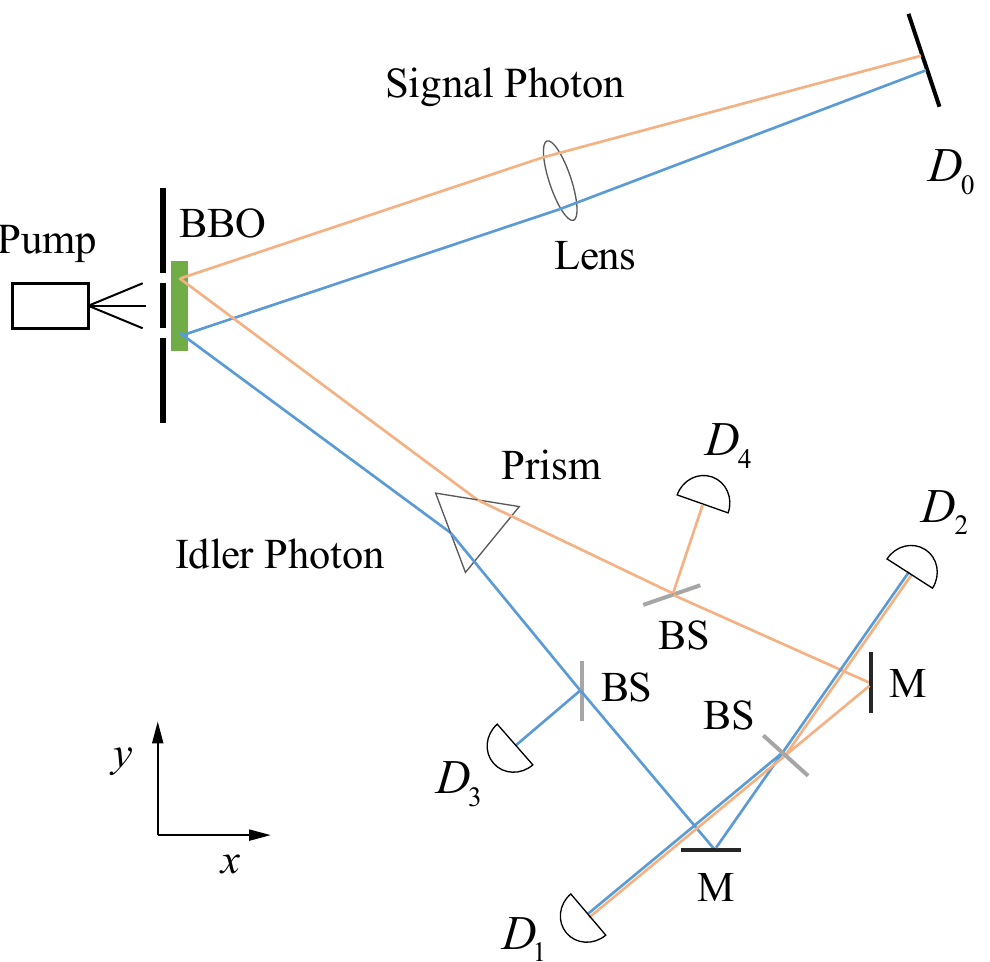
Figure 2: A delayed choice quantum eraser experiment. A laser beam aims photons at a double slit. After a photon passes the slits it impinges on a barium borate (BBO) crystal placed behind the double slit. The optical crystal destroys the incoming photon and creates an entangled pair of photons via spontaneous parametric down conversion at the spot where it hit. Thus, if one of the photons of the entangled pair can later be identified by which slit it went through, one also knows whether its entangled counterpart went through the one or the other side of the crystal. Whether which-path information about the signal photon arriving at detector D 0 is obtained or erased is decided by manipulating the idler photon well after the signal photon has been